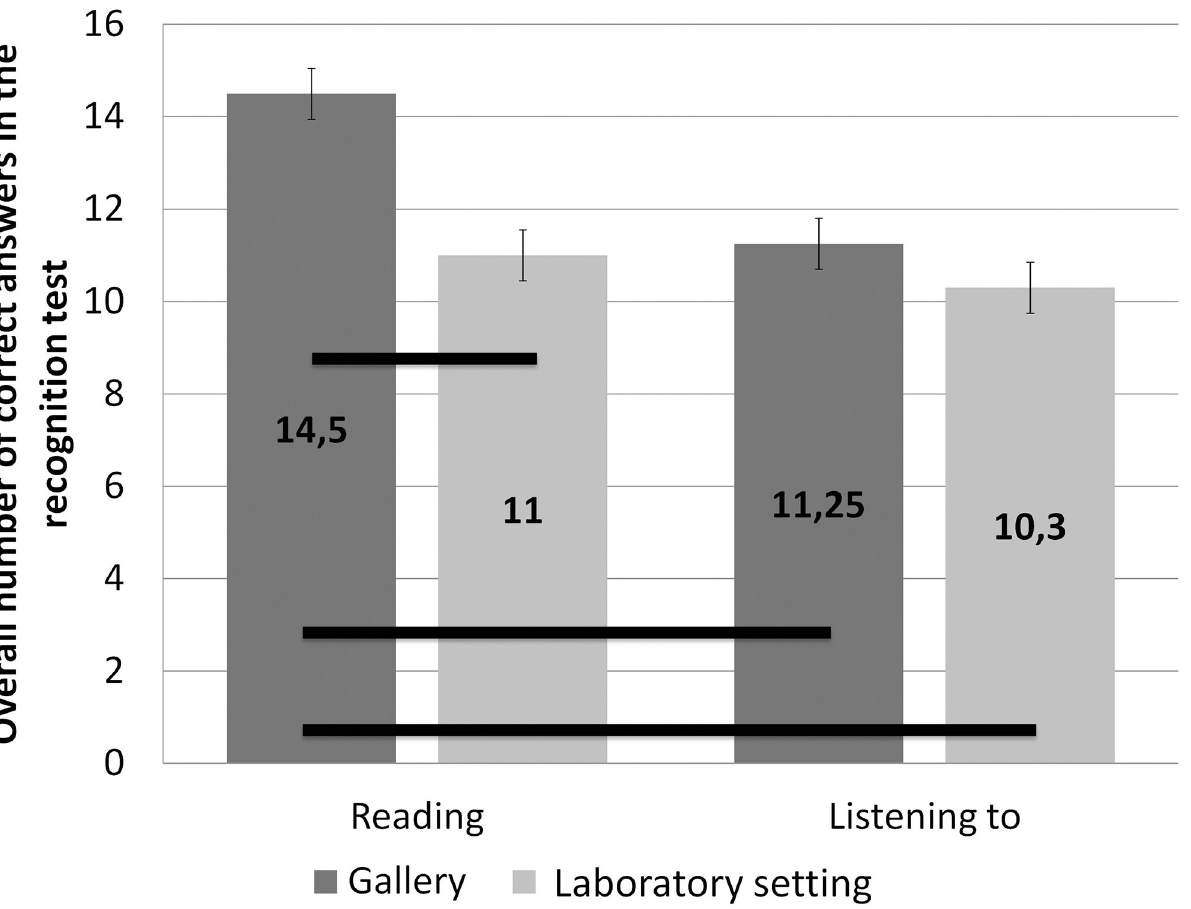
Fig 1. An interaction effect between the way of providing contextual information and the situational context on the memory of curatorial information. Error bars represent +/- 1 standard